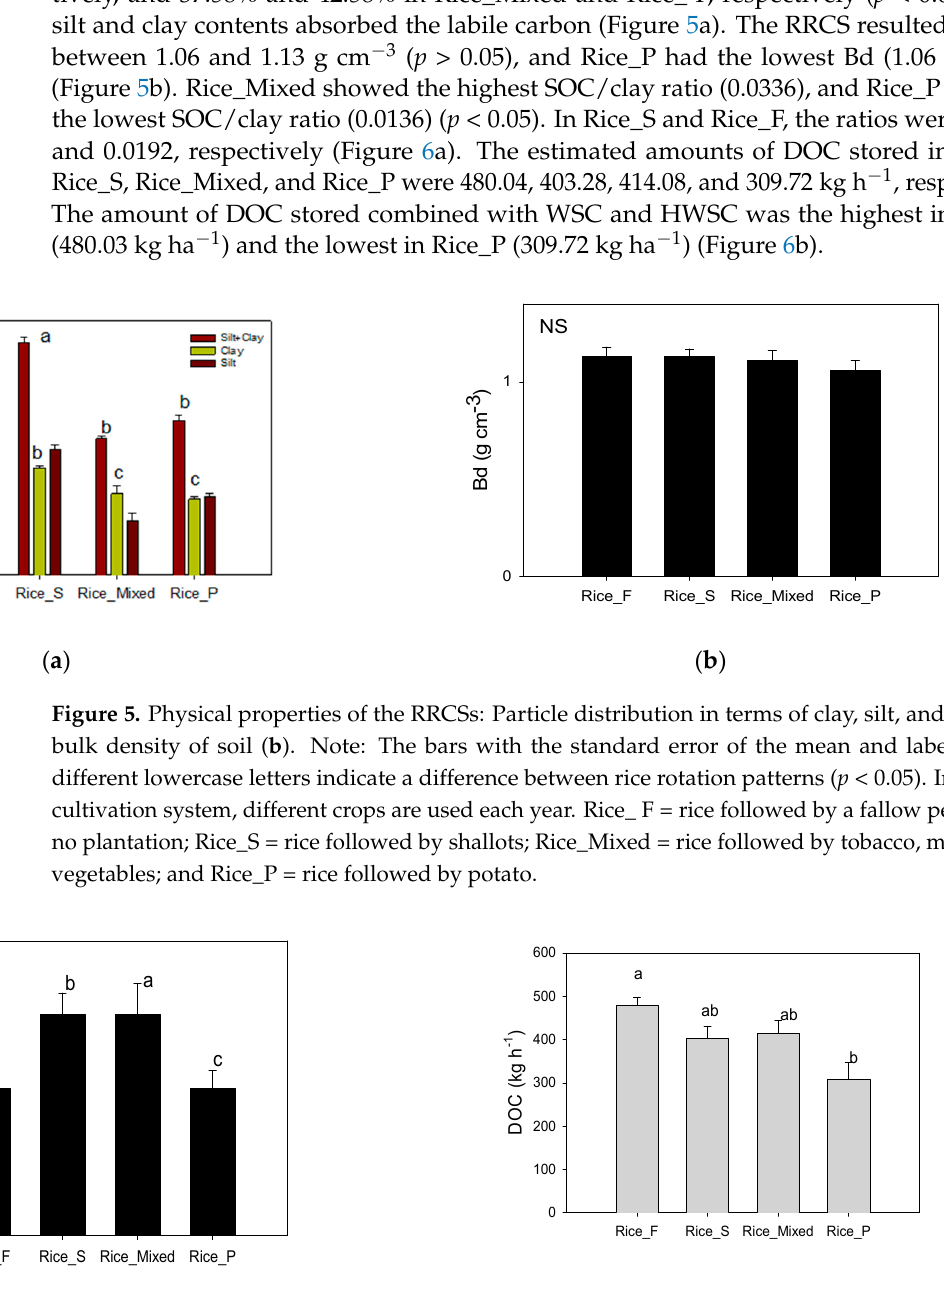
9 of 21 mean and labeled with different lowercase letters indicate a difference between rice rotation pat- terns ( p < 0.05). In the rice cultivation system, different crops are used each year. Rice_ F = rice fol- lowed by a fallow period, i.e., no plantation; Rice_S = rice followed by shallots; Rice_Mixed = rice followed by tobacco, maize, and vegetables; and Rice_P = rice followed by potatoes.